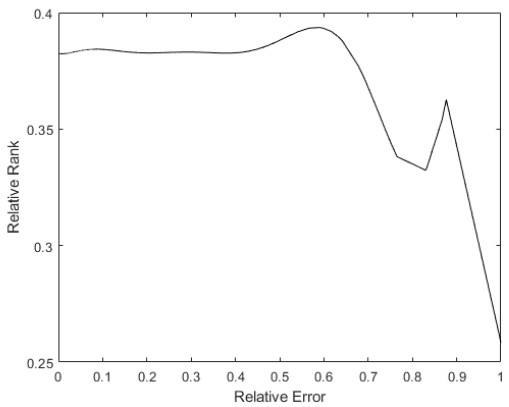
Figure 19. Polynomial regression of relative rank to relative error on X 4 .